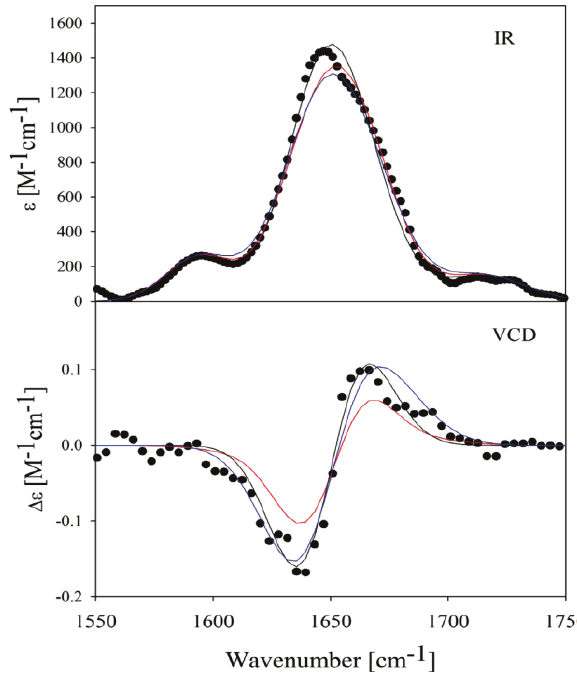
Figure 10. Amide I’ region of the infrared and vibrational circular dichroism spectra of W in D O. The red lines result from a simulation using a conformational distribution A 5 2 reflecting the Ramachandran plot obtained from MD simulations with a ff03* force field. The black lines reflect the results of a fit with an adjustable conformational model describable as superposition of two-dimensional Gaussian distributions associated with pPII, (cid:8)-strand, right-handed helical, and inverse (cid:16)-turn-like conformations. The blue line was computed with a refined model, which additionally considered a further modified distribution as mentioned in the results. (Taken from ref. [153] with